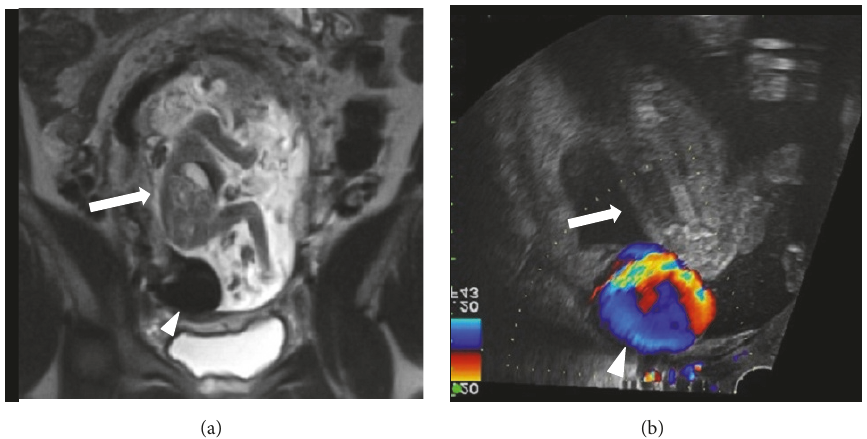
Figure 3: Maternal coronal (sagittal fetal) T2-weighted image of the pelvis (a) at 18 weeks of gestation with similar fetal positioning in relation to the lesion on ultrasound (b) as if the fetus (arrow) is sitting (or bouncing) on the lesion (arrowhead). Note the Yin/Yang swirling flow on color